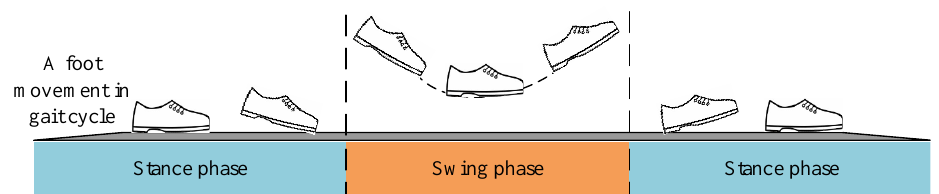
Figure 1. Pedestrian gait